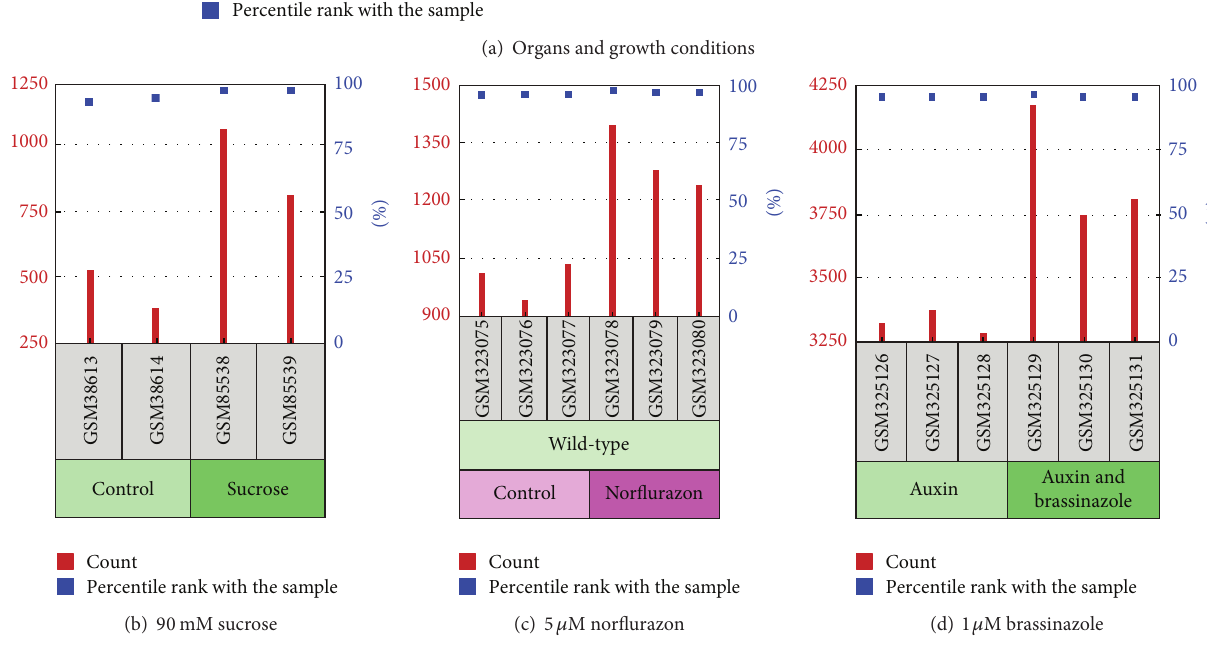
Figure 3: Peroxisomal 6PGDH gene (At3g02360) expression in Arabidopsis thaliana grown under different conditions. (a) Expression of p6PGDH in leaves of 15-day-old plants, stems and flowers of 29-day-old plants grown in either growth chamber or greenhouse conditions. (b) Effects of a 6h long treatment with 90 mM sucrose to 4-day-old, dark-grown Arabidopsis seedlings. (c) Effects of 5 𝜇 M norflurazon to 5-day-old, continuous light Arabidopsis seedlings. (d) Auxin effect on 10-day-old seedlings treated for 8 h either 0.1 𝜇 M 2,4-D or 0.1 𝜇 M 2,4-D plus 1 𝜇 M brassinazole. Data were obtained from the Gene Expression Omnibus (GEO) database and analyzed using Affymetrix Microarray Suite 5.0 (MAS5). The original sample accessions (GSMxxx) are listed in the gray boxes along the bottom of the